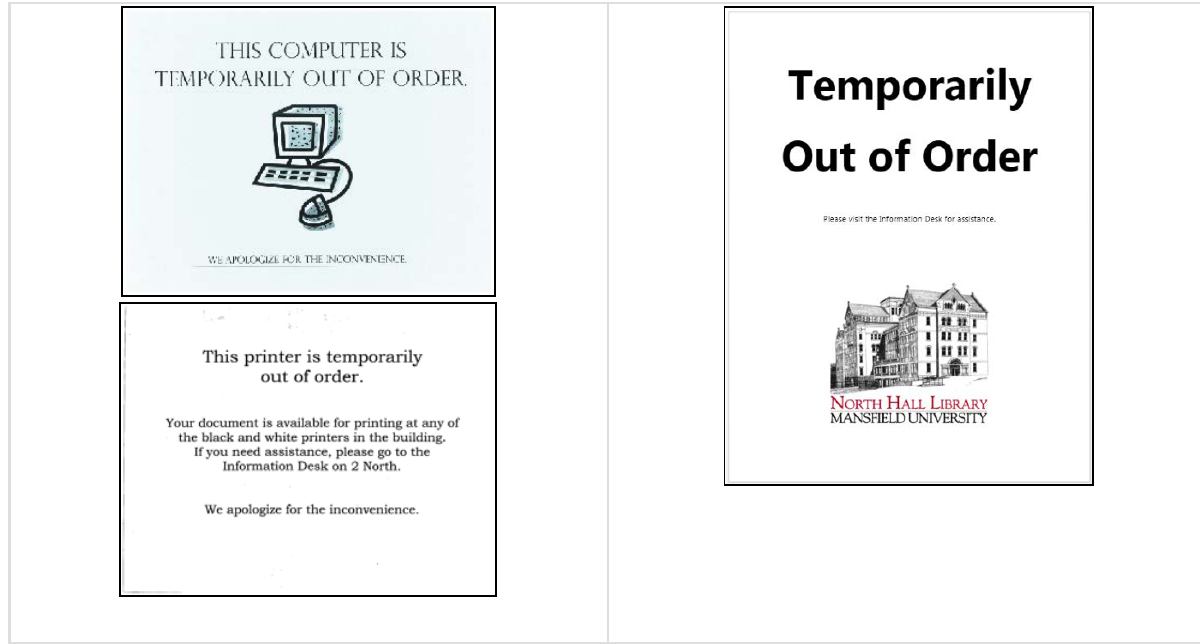
The library had a variety of “Out-of-Order” signs (left) for copiers, computers, printers, etc. A single out-of-order sign (right) that is useful in all situations offers a more professional look. The large font is easy to read. The library logo makes this sign appear